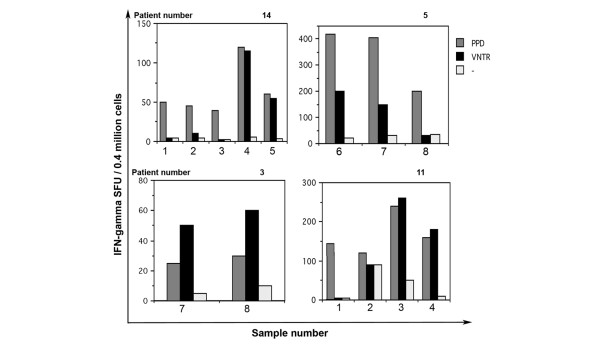
IFN-γ secreting T cells in patients immunized with M-FP. Patient numbers 14, 5, 3 and 11 are shown. Responses to VNTR (pVNTR (which contains five VNTR repeats with no GST); black), PPD (internal positive control; grey) and no antigen (negative control; white). 1 = first injection; 2 = week 6 (2 weeks after the third injection); 3 = week 12 (2 weeks after the sixth injection); 4 = 6 months (3 months after the seventh injection); 5 = 9 months (3 months after the eighth injection); 6 = 1 year (3 months after the final (ninth) injection); 7 = 2 years, and 1 year and 3 months after the final injection; 8 = 3 years, and 2 years and 3 months after the final injection. GST, glutathione-S-transferase; IFN, interferon; M-FP, oxidized mannan conjugated to MUC1 fusion protein; PPD, purified protein derivative; SFU, spot forming units; VNTR, variable number of tandem repeats (from MUC1 sequence).